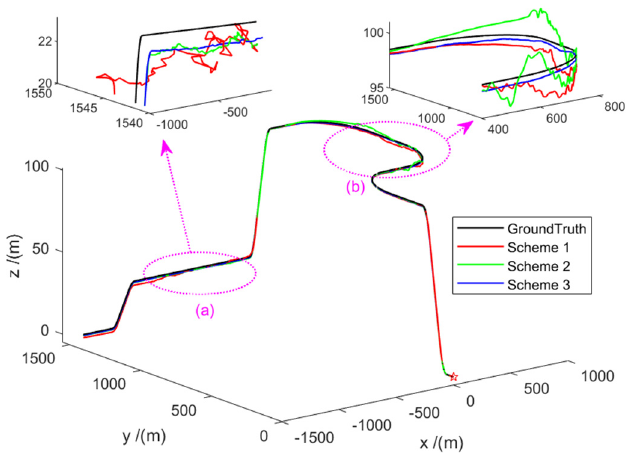
Figure 5. Comparison of trajectories of different schemes. Asterisk indicates the starting position, the dotted line indicates the position of the enlarged area, and the arrow indicates the specific enlarged area ( a , b ).